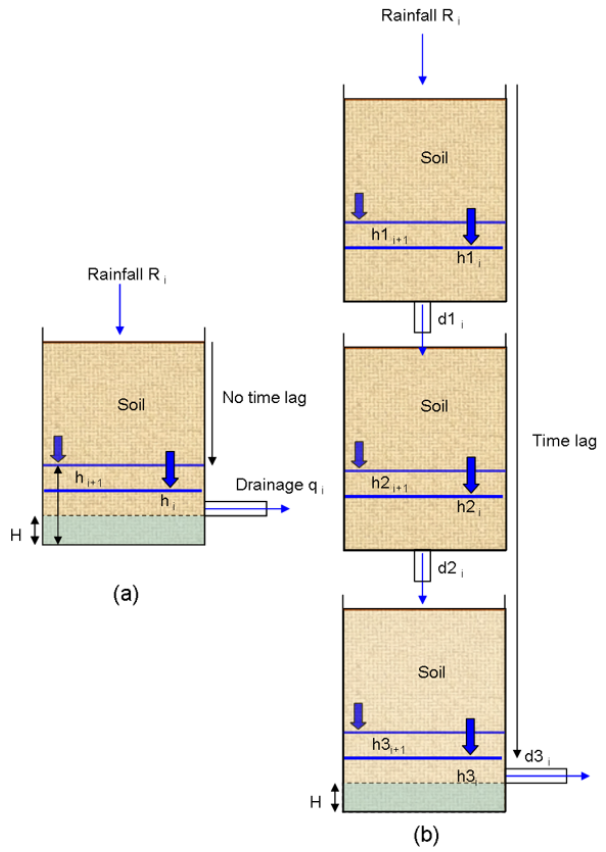
Figure 1. Details of simple tank model and multi-tank model ap- plied in deep-seated landslides. (a) Schematic diagram of simple tank model. (b) Schematic diagram of multi-tank